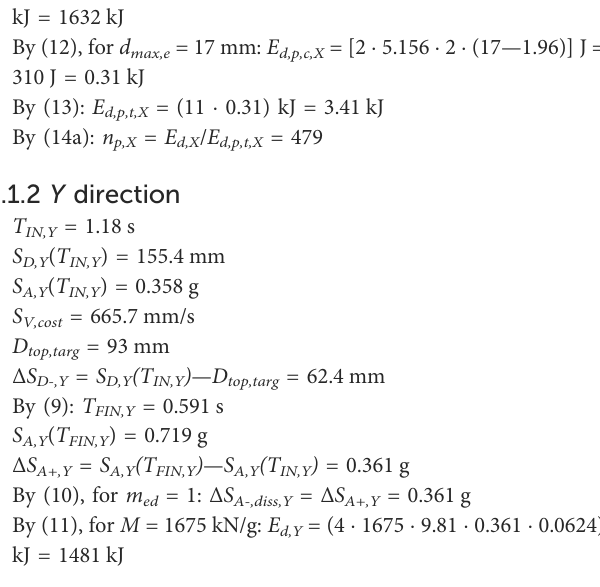
Frontiers in Built